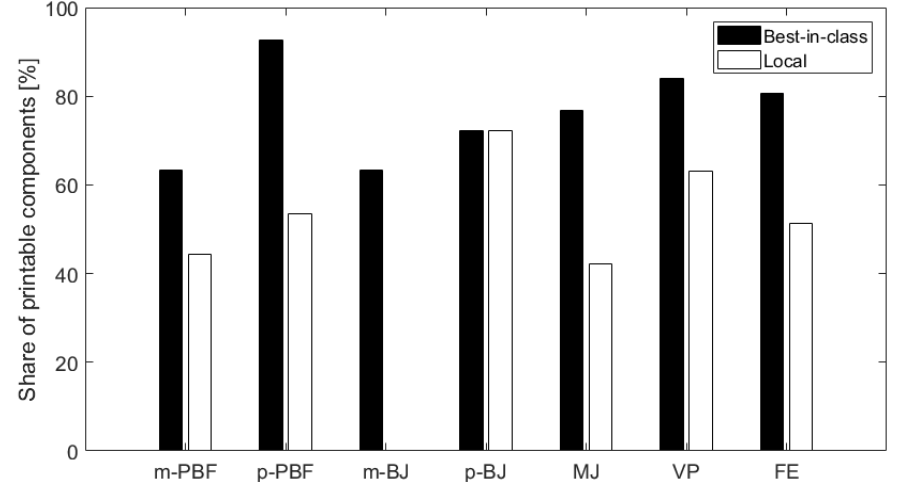
Figure 4. Percentages of printable components according to their size (printed as one component). m-